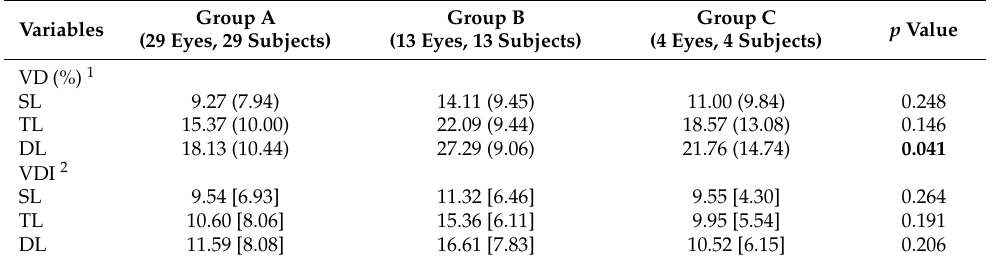
Table 6. The influence of prostaglandin administration on vasculature parameters. Variables